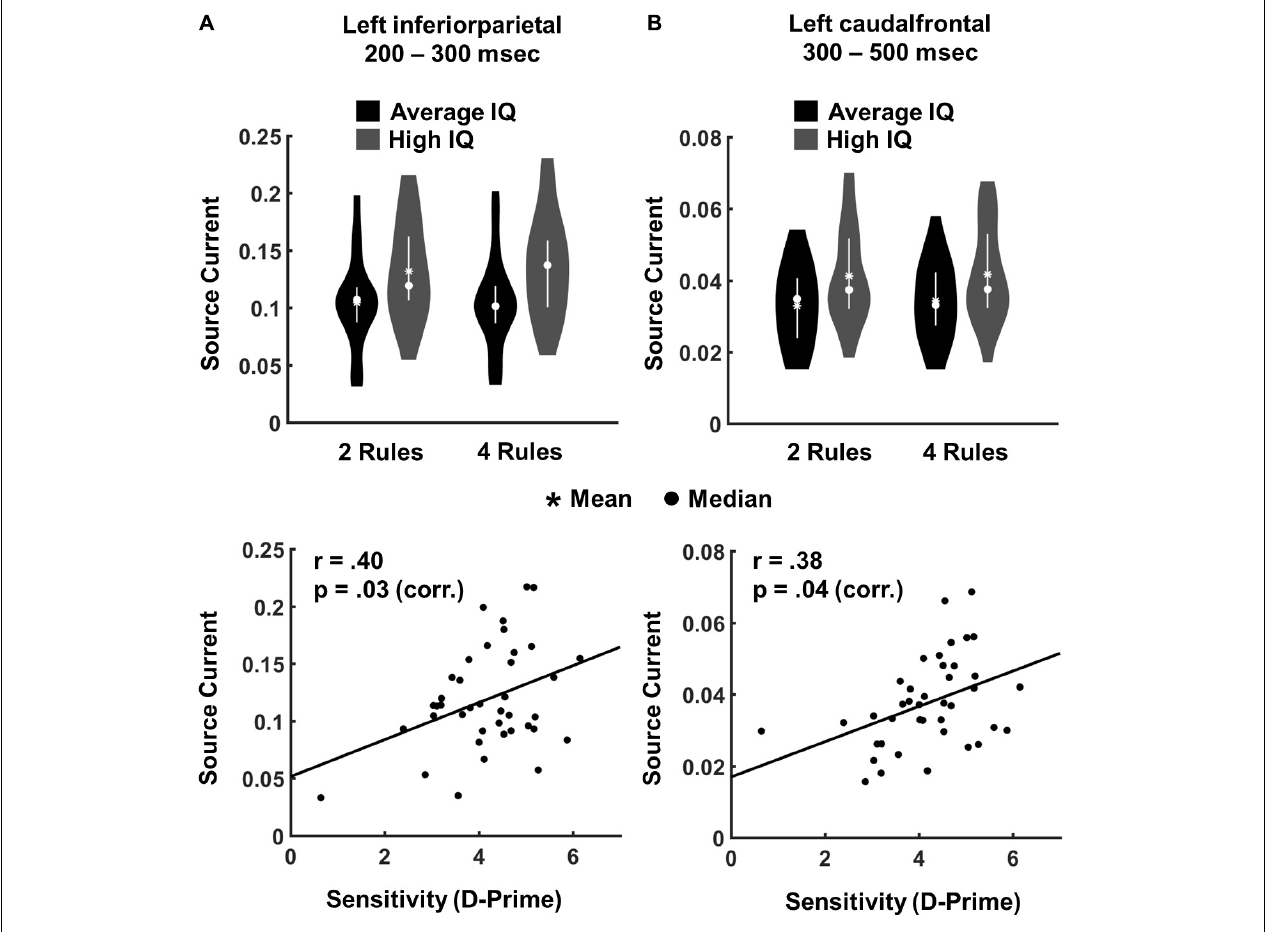
FIGURE 4 | Region of interest analyses in pre-defined time windows. (A) The plot shows EEG source current indicating the significant main effect of IQ group in left inferiorparietal cortex in the 200–300 ms time window, and the significant correlation between EEG source current and task performance (d’ scores). (B) EEG source current indicating the significant main effect of IQ group in left caudalfrontal cortex in the 300–500 ms time window, and the significant correlation between EEG source current and task performance (d’